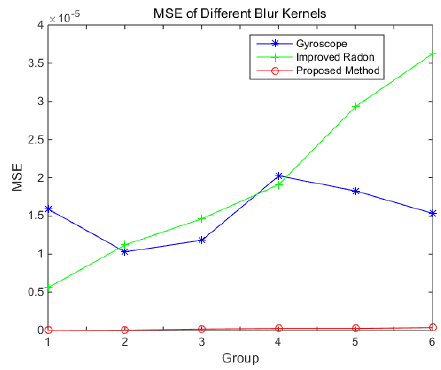
Figure 11. Mean square error (MSE) of the blur kernel by different method.